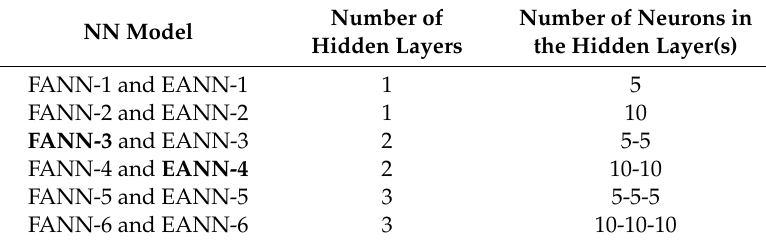
Table 5. Architectures of the examined artificial neural network (ANN) strength (F) and strain (E)